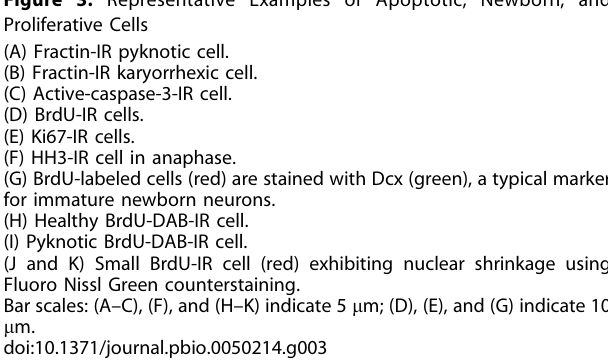
group effect: F 1,20 ¼ 12.57, p , 0.01) and, as expected, an increase in cell death (Figure 5C, group 3 age interaction F 1,20 ¼ 2.82, p ¼ 0.11; group effect: F 1,20 ¼ 27.34, p , 0.001; and Figure 5D, group 3 age interaction F 1,20 ¼ 1.83, p ¼ 0.19; group effect: F 1,20 ¼ 35.78, p , 0.001).